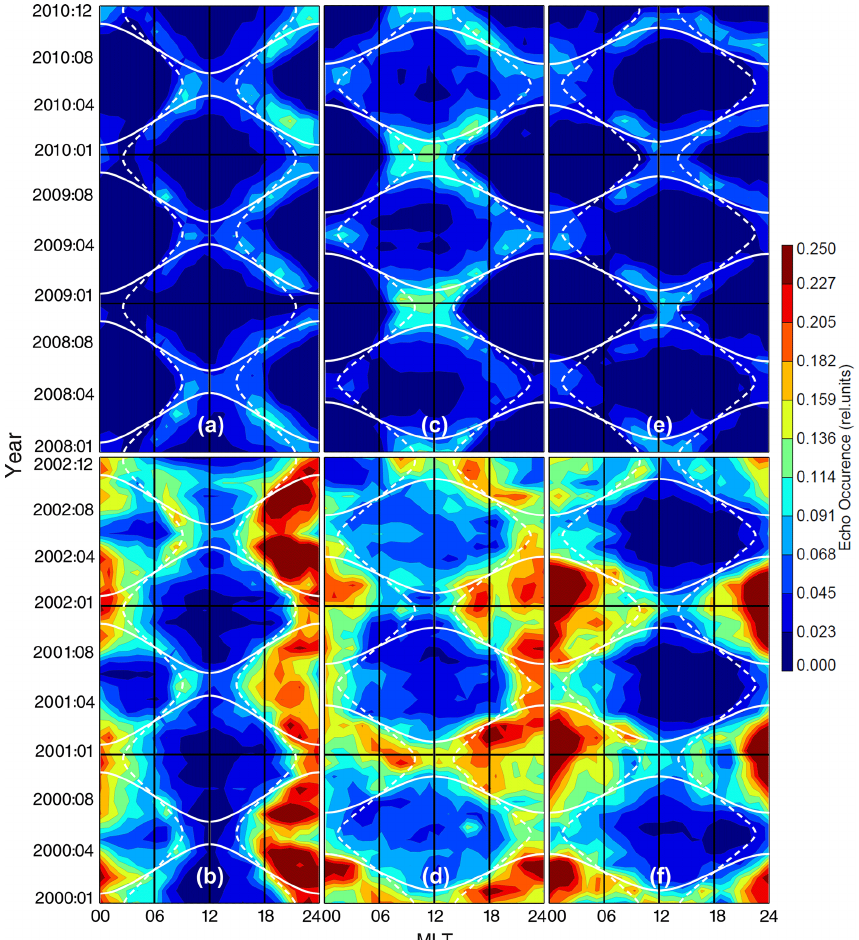
Fig. 5. Echo occurrence rates for periods of minimum solar activity (2008–2010, top row) and maximum solar activity (2000–2002, bottom row) as a function of MLT time for the Bruny Island (TIG, a and b ), Prince George (PGR, c and d ) and Hankasalmi (HAN, e and f ) SuperDARN radars. Roughly meridional beams for each radar were considered as indicated in Fig. 1b, c, d. Only magnetic latitudes of F region echo detection were considered. The dashed and solid white lines represent the terminator line at the earth’s surface for, roughly, the expected centers of the one-half-hop and 1.5-hop echo